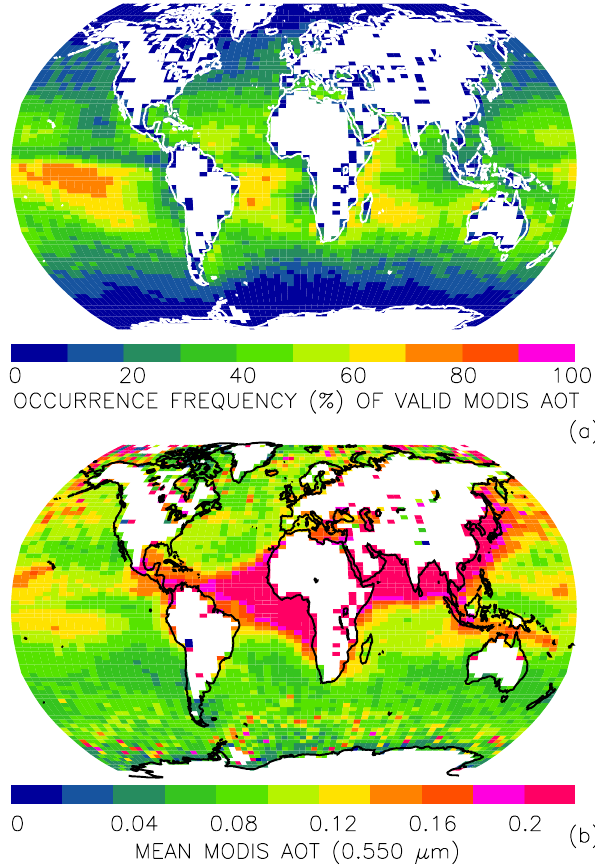
(“good” or “very good”) over-ocean level 2 (L2) MODIS AOT re- trievals, relative to all over-ocean L2 MODIS AOT retrievals, for every 2 ◦ × 5 ◦ latitude–longitude grid box. Also shown is (b) the corresponding spatial distribution of mean L2 MODIS AOT for the same time period. This analysis includes only those MODIS points collocated with